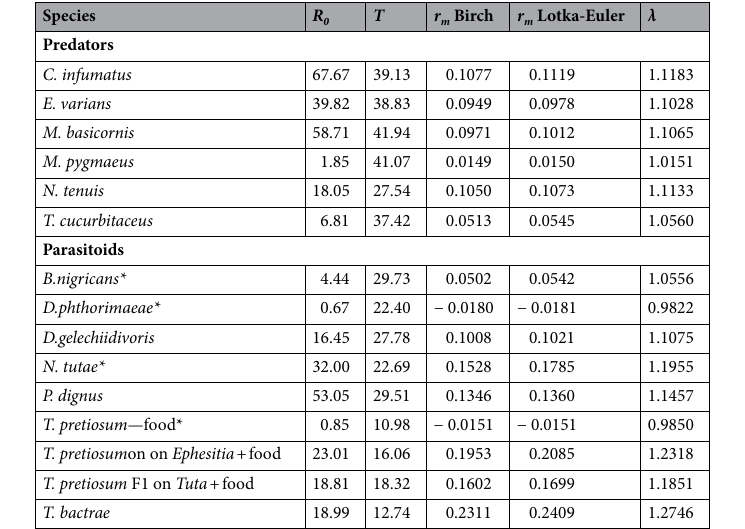
Table 2. Life-table parameters for six predator species and seven parasitoid species. R 0 = net reproductive ratio; T = mean generation time; r m = intrinsic rate of increase; λ = the finite rate of increase; * parasitoid with non-reproductive host killing/feeding; r m values found for the pest T. absoluta are provided in supplementary material file S16, together with references for the papers presenting these